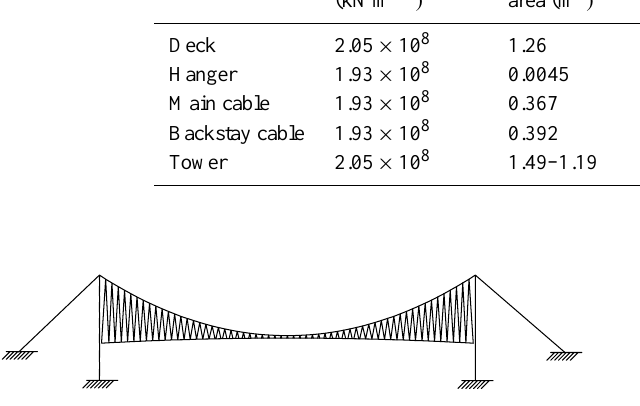
Fig. 7. Two-dimensional finite element model of Bosporus Suspension Bridge.